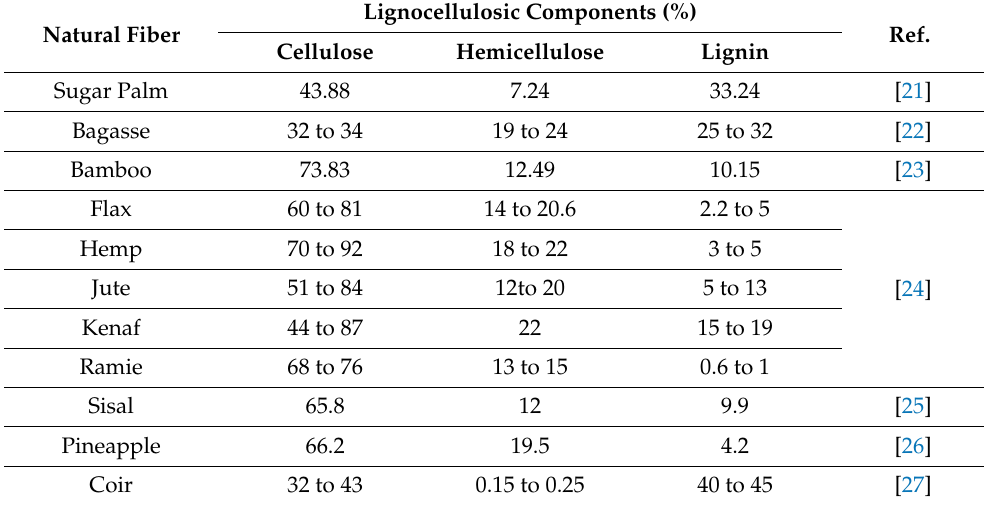
Table 1. Chemical composition of natural fibers.